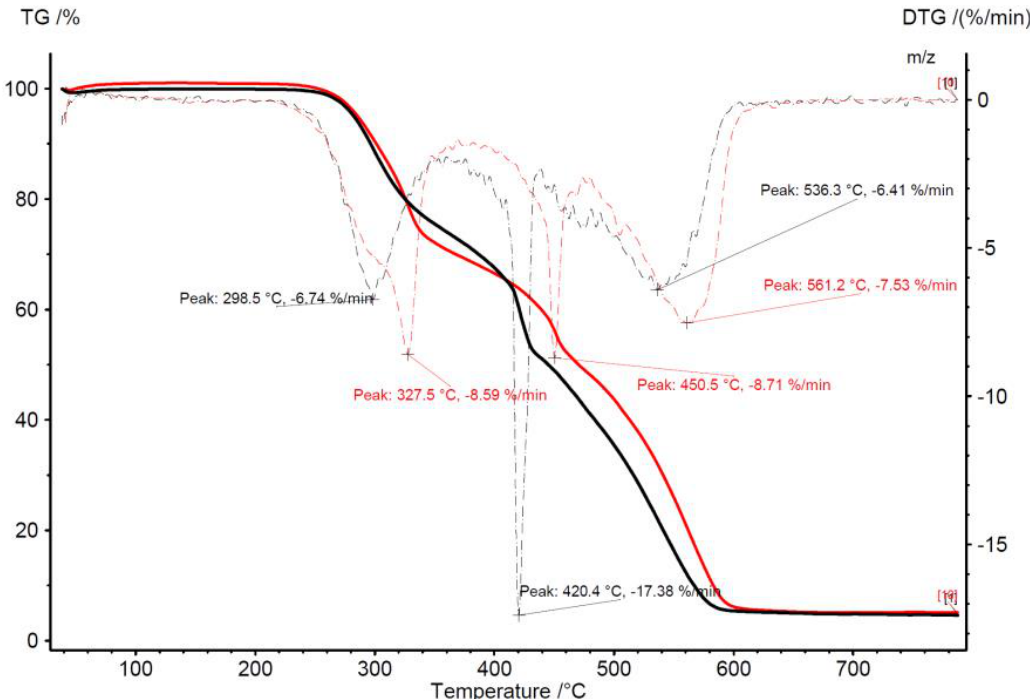
Figure 10. TGA-MS analysis of the torrefied Jerusalem artichoke combustion process. Table 4. Content of elements in the ash from untreated Jerusalem artichoke and torrefied Jerusalem artichoke burnt biomass.